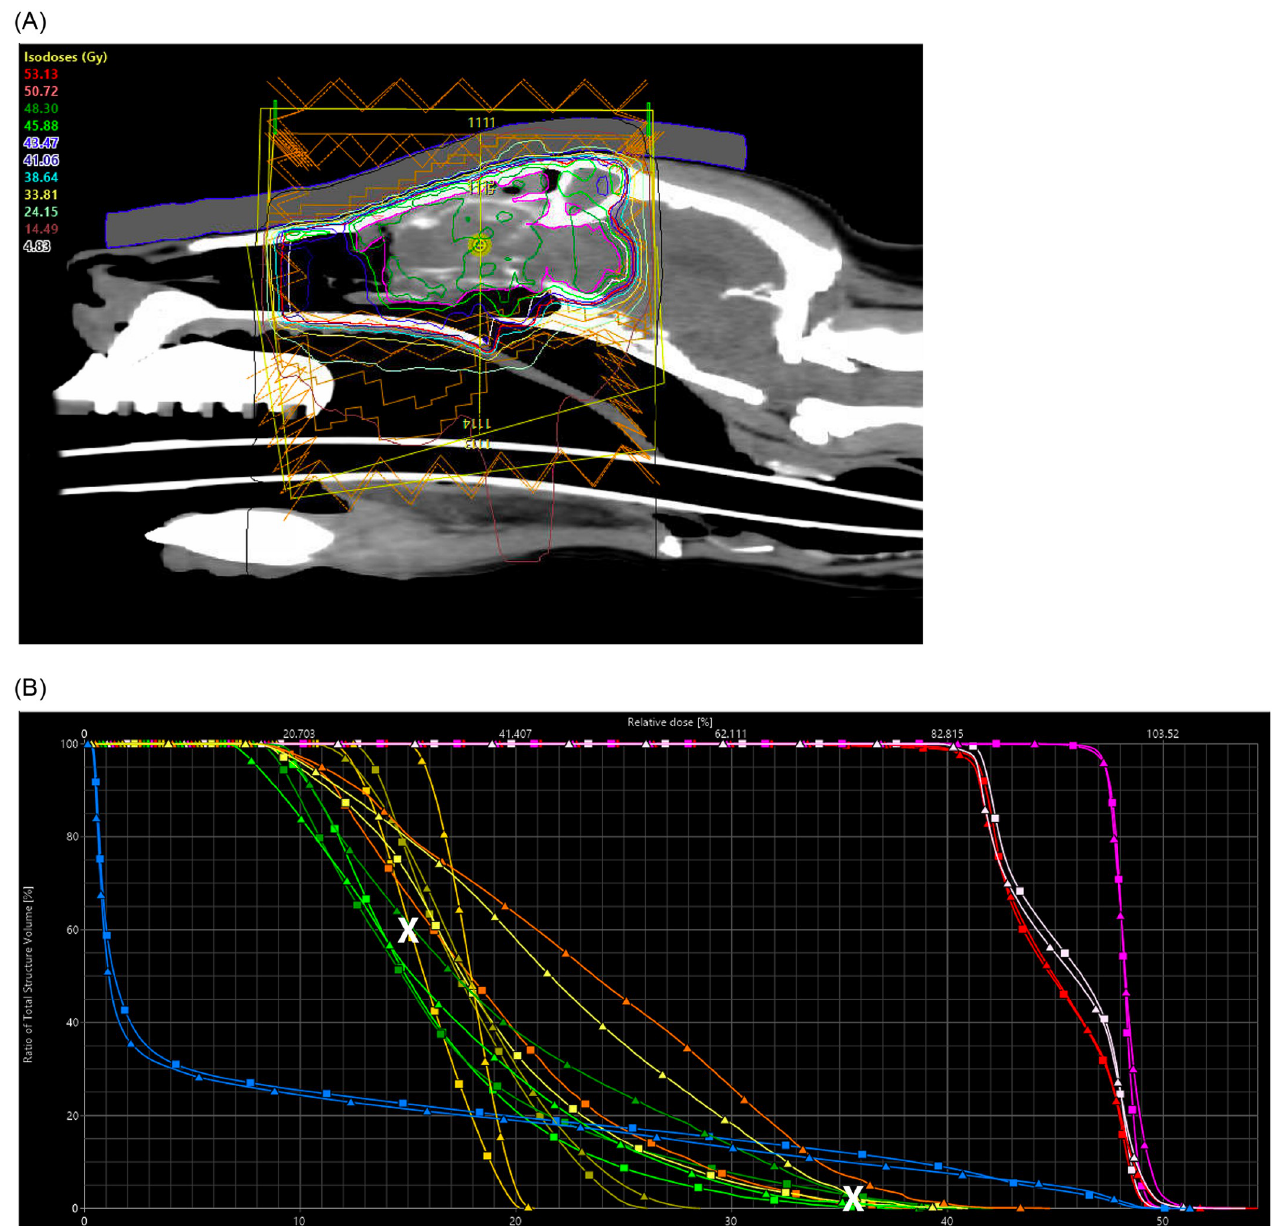
Fig 1. Radiation therapy plan and dose volume histogram. (A) Sagittal computed tomography image of a dog with a stage IV sinonasal tumor with marked intracranial invasion with gross tumor volume (GTV) shown in pink and radiation dose with isodose lines of the IMRT plan in color. (B) Comparison of the dose volume histograms of target volumes (GTV pink, CTV light pink, PTV red) and organs at risk (left cornea orange, right cornea yellow, left eye dark green, right eye light green, lacrimal glands darker yellow, brain blue) between fixed-field IMRT (squares) and VMAT (triangles) plan of the dog depicted in A. The aspired dose volume constraints for eyes (D60 < 15 Gy) and cornea (D2 < 35.4 Gy) are depicted with a white X.